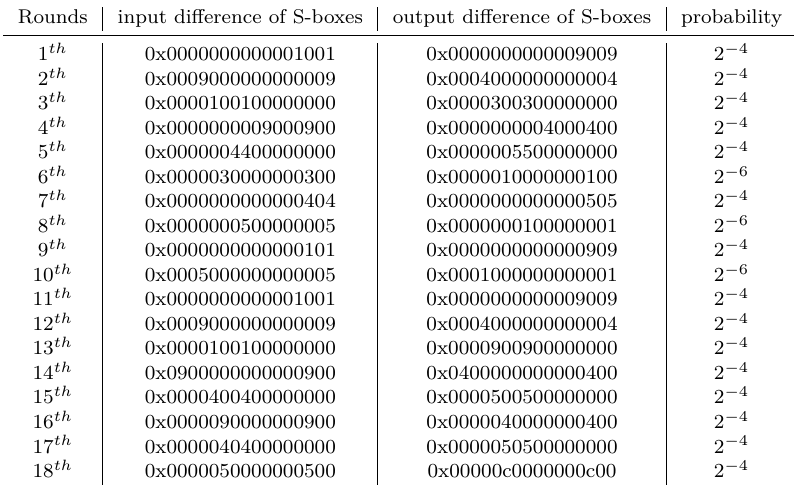
Table 8: The best differential characteristic with probability 2 − 78 for 18-round PRESENT.